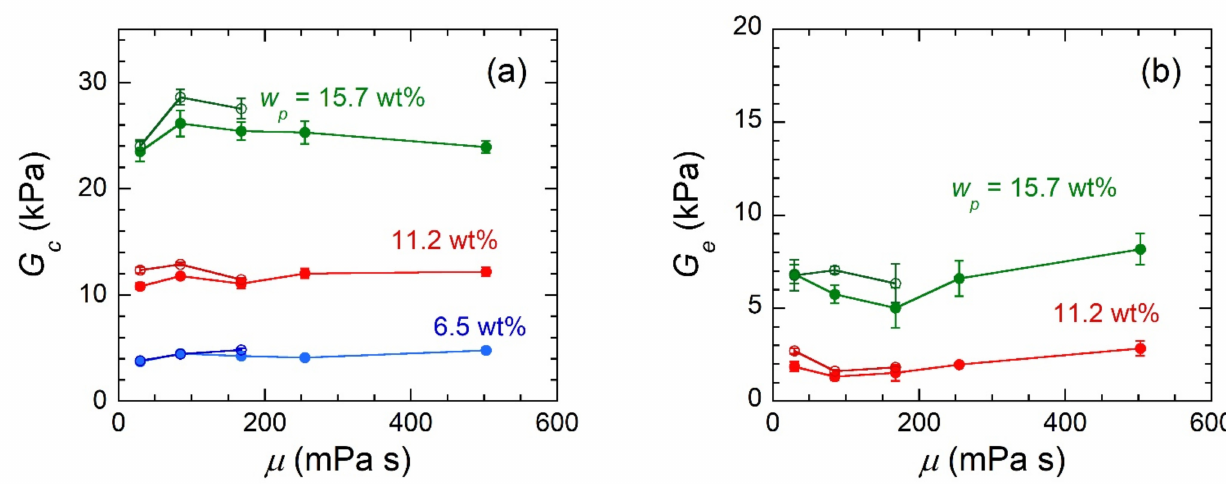
Figure 3. ( a ) Crosslinked network modulus contribution for gels composed of 0.5 wt% OA (filled symbols) or 1.0 wt% AOT (open symbols) and varying SEBS concentration (labeled) and oil viscosity. ( b ) Chain entanglement modulus contribution for gels composed of 0.5 wt% OA (filled symbols) or 1.0 wt% AOT (open symbols) and varying SEBS concentration (labeled) and oil viscosity. Lines serve as guides to the